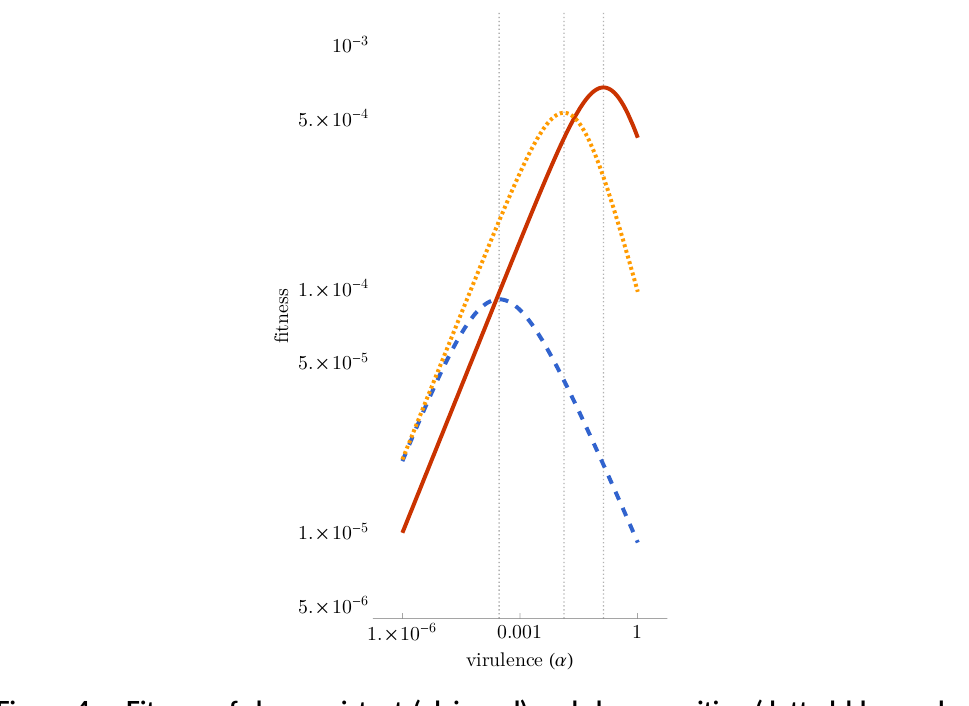
Figure 4 – Fitness of drug-resistant (plain red) and drug-sensitive (dotted blue and yellow) infections as a function of virulence. This illustration assumes trade-offs be- tween virulence and transmission rate ( β ( α ) = β 0 α p ) and treatment rate and virulence ( γ ( α ) = g α q ). In the blue dashed case, treatment rate is more intense against virulent infections ( g = 10 ) than in the dotted yellow case ( g = 0.1 ). Vertical lines show the ESS values. Parameter values are β 0 = 10 − 4 , p = 0.4 , q = 0.75 , µ + ν = 0.02 , a = 0.1 and b = 0.5